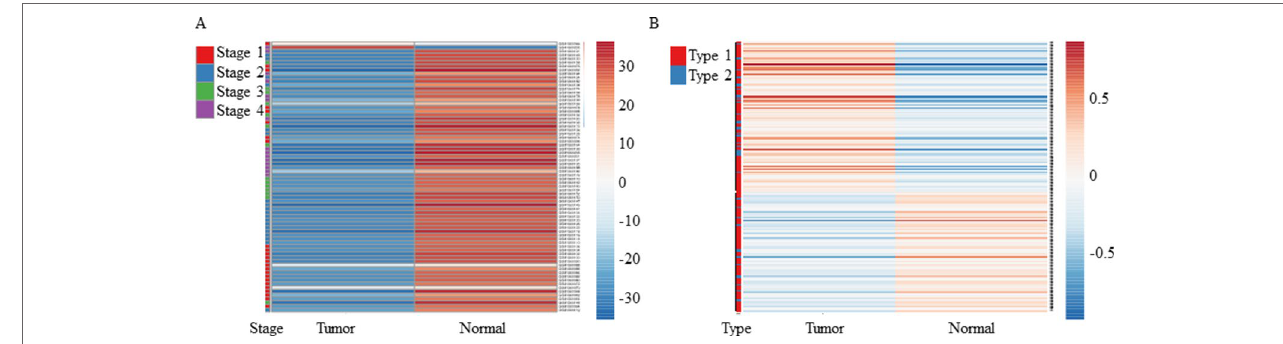
FIGURE 1 | Heatmap showing the expression of MuD from microarray data. MuD expression in kidney renal clear cell carcinoma (A) and adjacent kidney tissue as well as in breast cancer (B) and adjacent breast tissue. Clustering was performed with ClustVis using NIPALS PCA method. Red – white – blue scale was used to depict the normalized expression level. Red, blue, green, and violet color bars were used in clear cell renal carcinoma to represent classified stages, whereas red and blue bars were used in breast cancer to represent the diagnosis type.